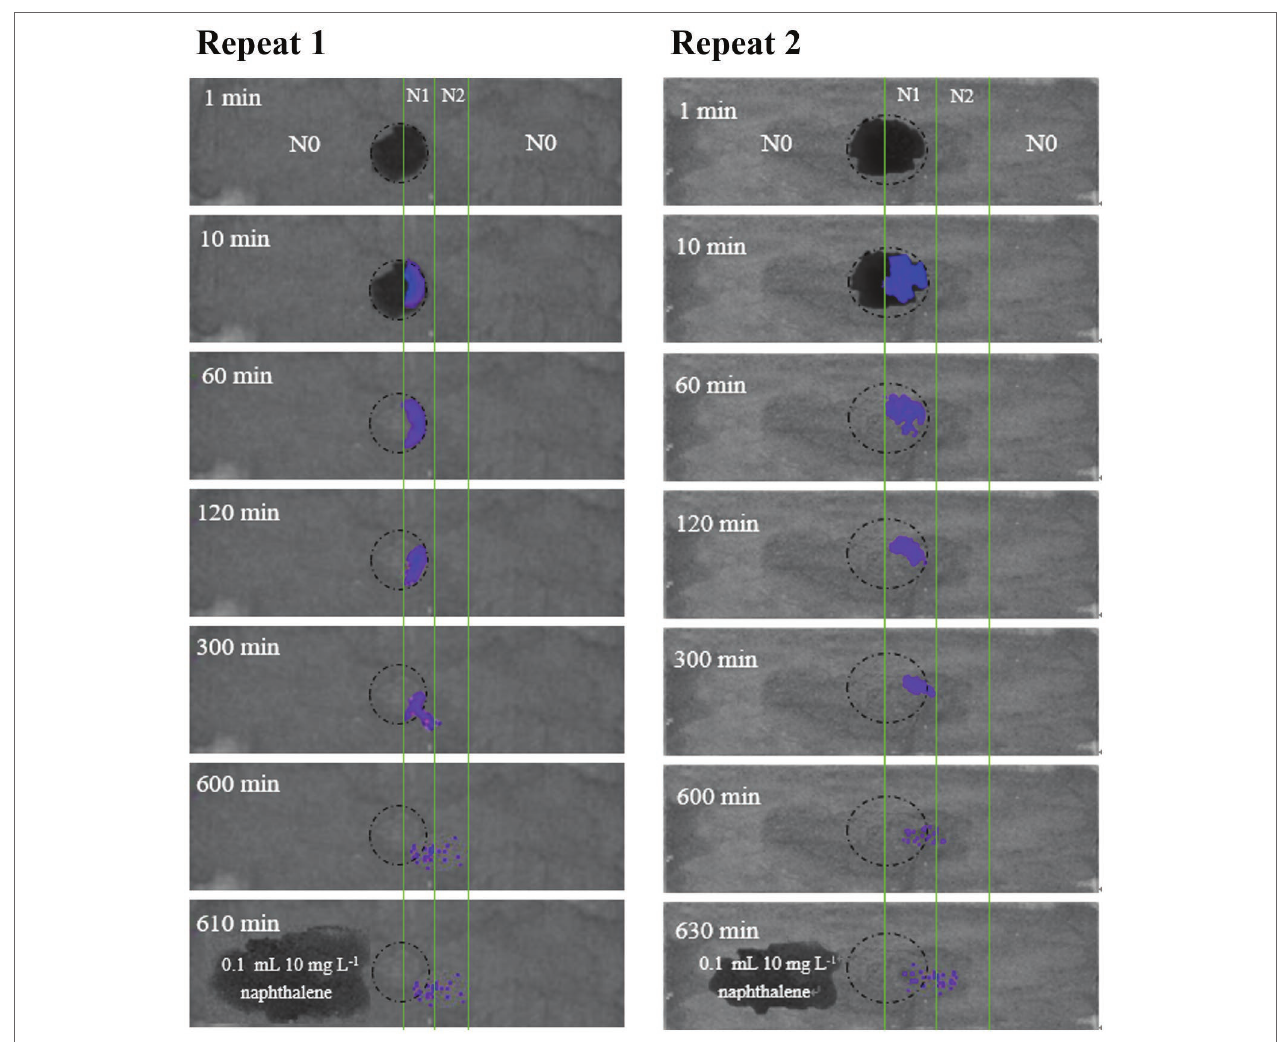
FIGURE 3 | Bioluminescent images of the movement of Pf 5RL in a 0.2-mm air-dried layer of sterilized chestnut soil colloids uniformly deposited on duplicate glass slides (2.5 cm × 7.6 cm). The soil colloid layer was divided into three parallel strips with strip N0 representing areas with no naphthalene soil adsorption, strip N1 representing an area of low naphthalene soil adsorption (47 mg kg − 1 ), and strip N2 representing an area of high naphthalene soil adsorption (90 mg kg − 1 ). The circle represents the area on the slide where a drop of Pf 5RL cell suspension was placed between the boundary line of N0 and N1. Bioluminescent images of the slide were then acquired in the IVIS Spectrum instrument at time points of 1, 10, 60, 120, 300, and 600 min after placement of the Pf 5RL cell suspension. After the 600 min time point, a 10 mg L − 1 drop of naphthalene was placed in the N0 area and an image was taken at either 610 or 630 min. The resulting lack of bioluminescence within this area of naphthalene addition indicated that the Pf 5RL cells did not move into the N0 area of the soil colloid